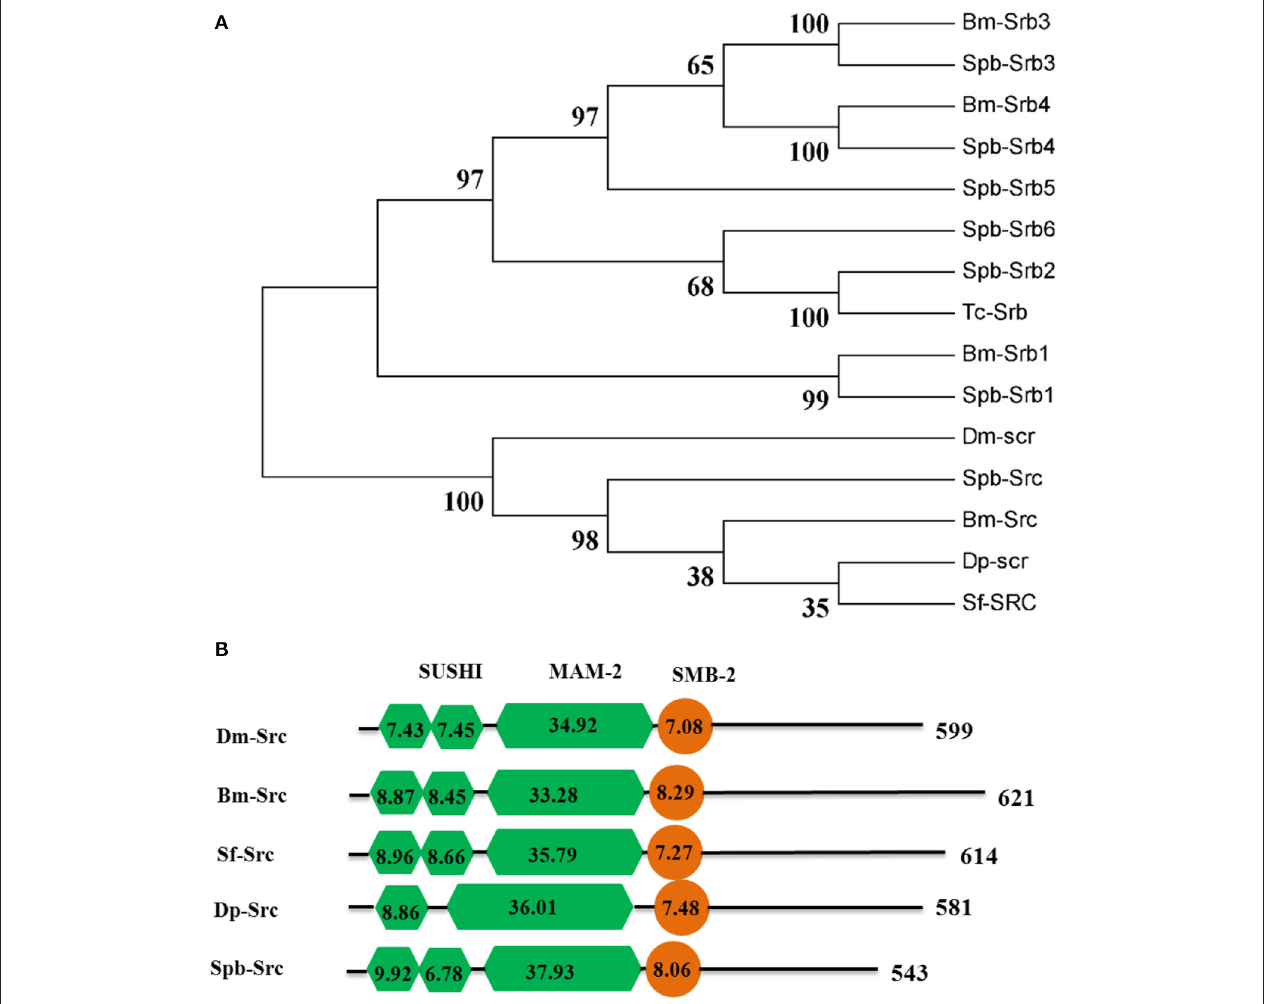
FIGURE 7 | Phylogenetic and domain architecture analysis of scavenger receptor proteins. (A) Neighbor-joining inferred phylogenetic relationships among insect scavenger receptor proteins, including BmSrb3 (NP_001164650), SpbSrb3 (C74700), BmSrb4 (NP_001164651), SpbSrb4(C66328), SpbSrb5 (C61934), SpbSrb6 (C76572), SpbSrb2 (C78248), BmSrb1 (XP_971917), SpbSrb1 (C75587), TcaSrb (XP_001164151), DmSrc(AFF58551), BmSrc (NP_001128387), SfSrc (ABB9283), SpbSrc (C75587), DpSrc(EHJ6731). Bootstrap values (1,000 replicates) are provided next to the branches. (B) Domain architecture of scavenger receptor C proteins. The SUSHI, MAM-2, and SMB-2 domains are indicated. Bombyx mori ; Dm, Drosophila melanogaster ; Tc, Tribolium castaneum ; Sf, Spodoptera frugiperda ; Spb, soybean pod borer.